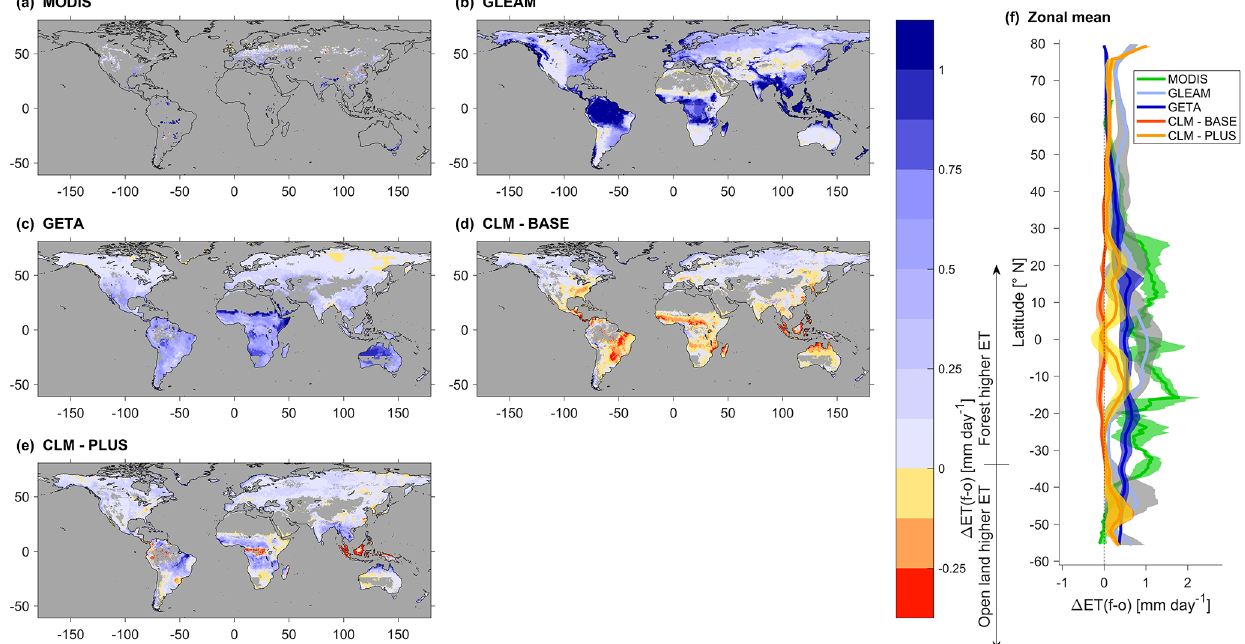
Figure 5. Annual mean (cid:49) ET (f − o) in (a) MODIS, (b) GLEAM, (c) GETA, (d) CLM-BASE, and (e) CLM-PLUS. Panel (f) shows the zonal mean (thick line) and the range between the 10th and 90th percentiles (shading) of MODIS (green), GLEAM (light blue, grey shading), GETA (dark blue), CLM-BASE (red), and CLM-PLUS (orange). Note that on this subfigure results have been smoothed with a 4 ◦ latitudinally running mean.